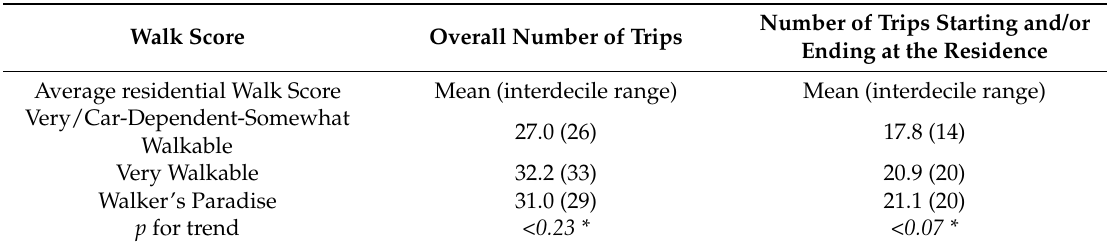
Table 1. Number of trips per participant (made with all motorized and non-motorized modes) over 7 days according to categories of Walk Score.